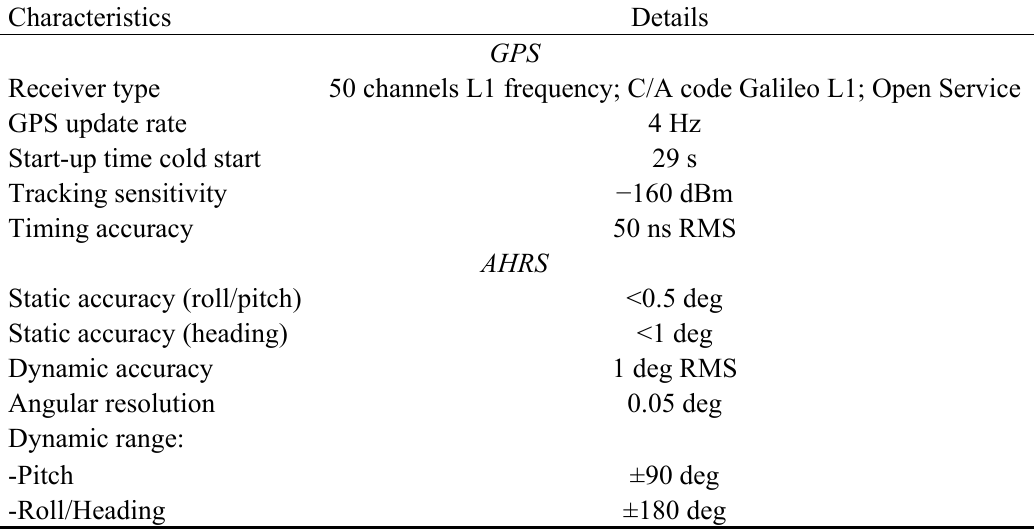
Table 3. Technical specifications of the ancillary instrument